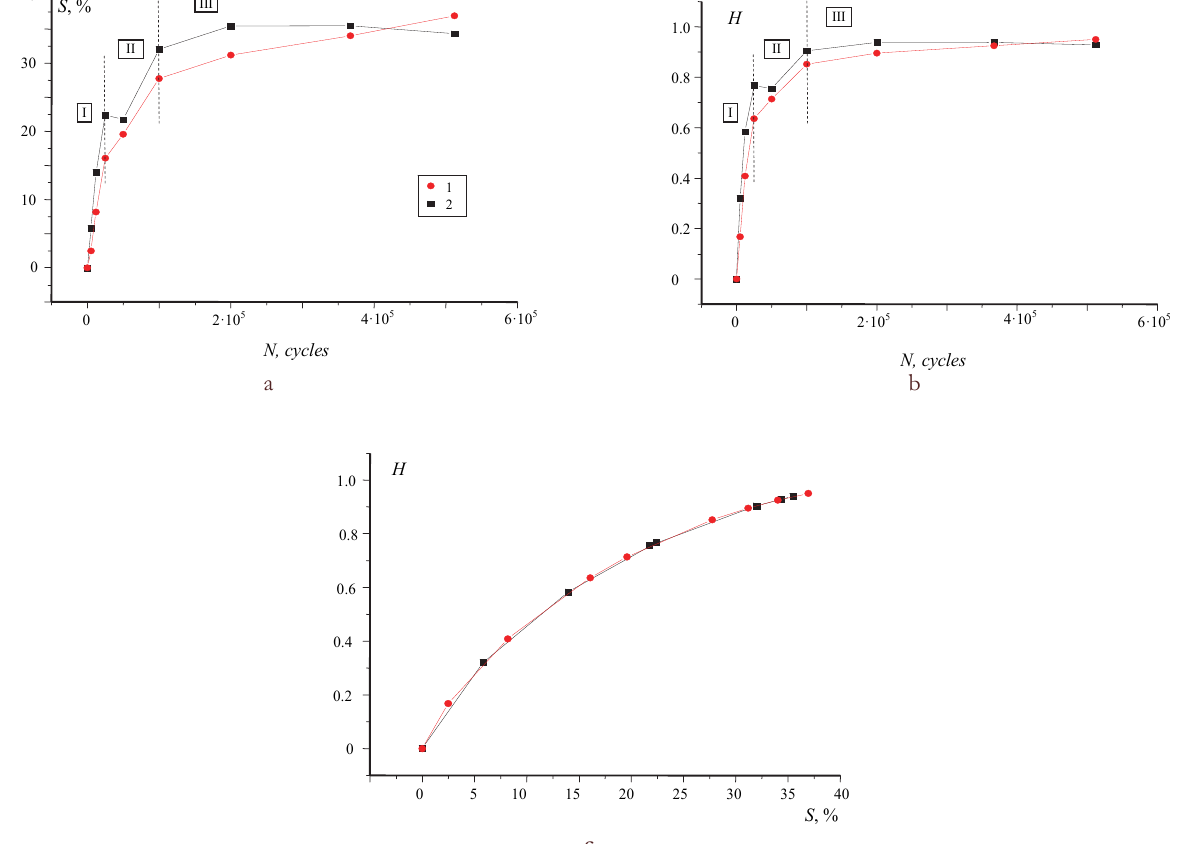
Figure 3: Dependence of the damaged area (S) – (a) and the Shannon entropy (H) – (b) versus the number of cycles and the S – to - H ration under cyclic bending. Images were taken from the right (1) and left (2) sides from the stress